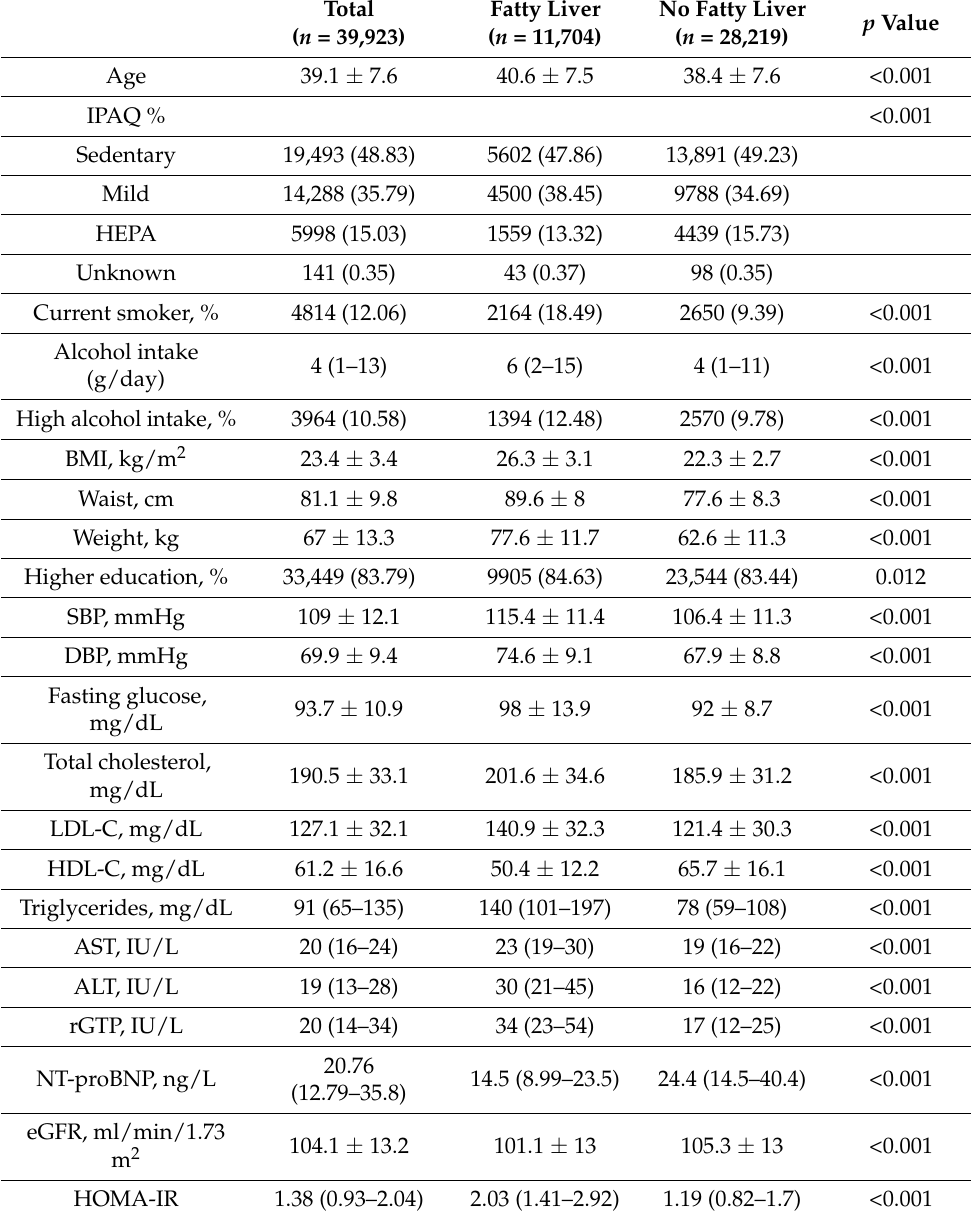
Table 1. Baseline characteristics according to fatty liver on abdominal